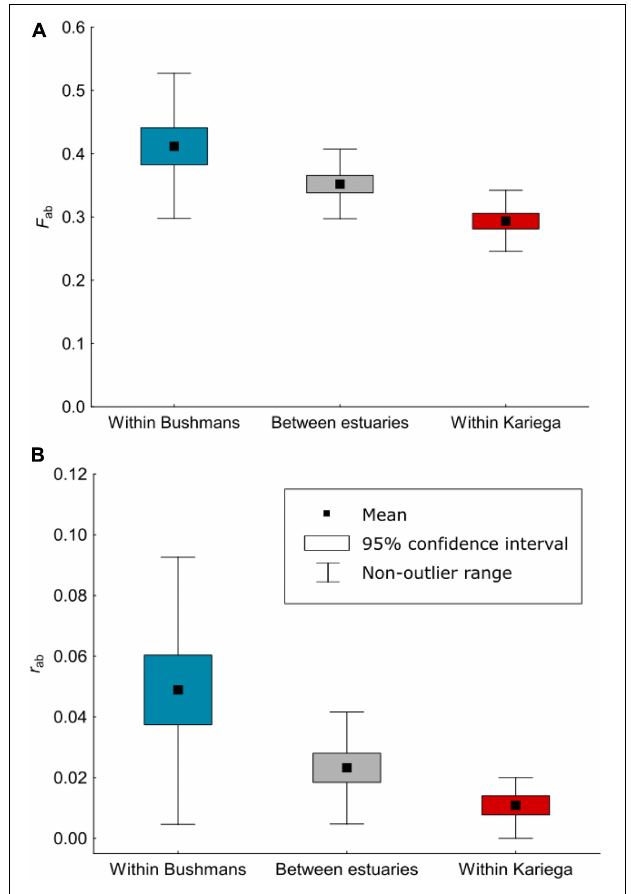
FIGURE 2 | Mean pairwise inbreeding coefficients (A) and mean pairwise relatedness coefficients (B) between individuals of Syngnathus watermeyeri within and between the two estuaries estimated from genomic data using a model of